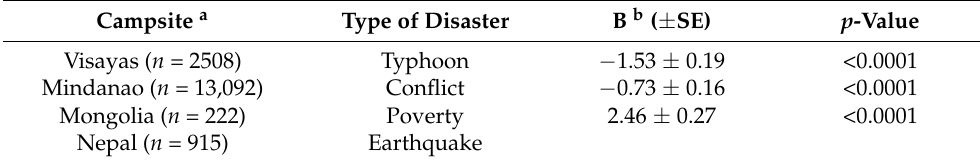
Table 2. Improvement in trauma symptoms by location for the four largest